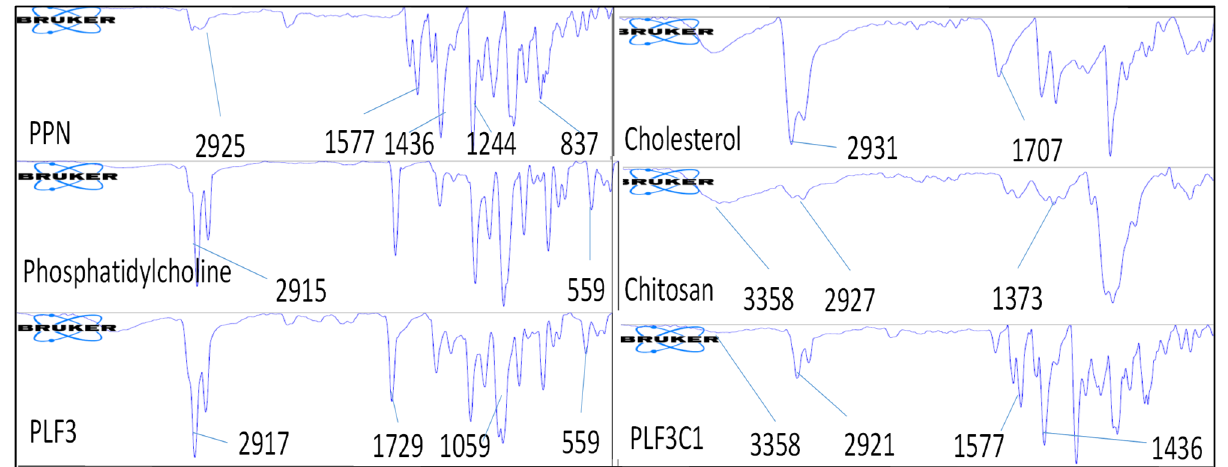
Figure 2. IR spectra of pure piperine, carriers and prepared chitosan-coated (PLF3C1) and uncoated liposomes (PLF3).